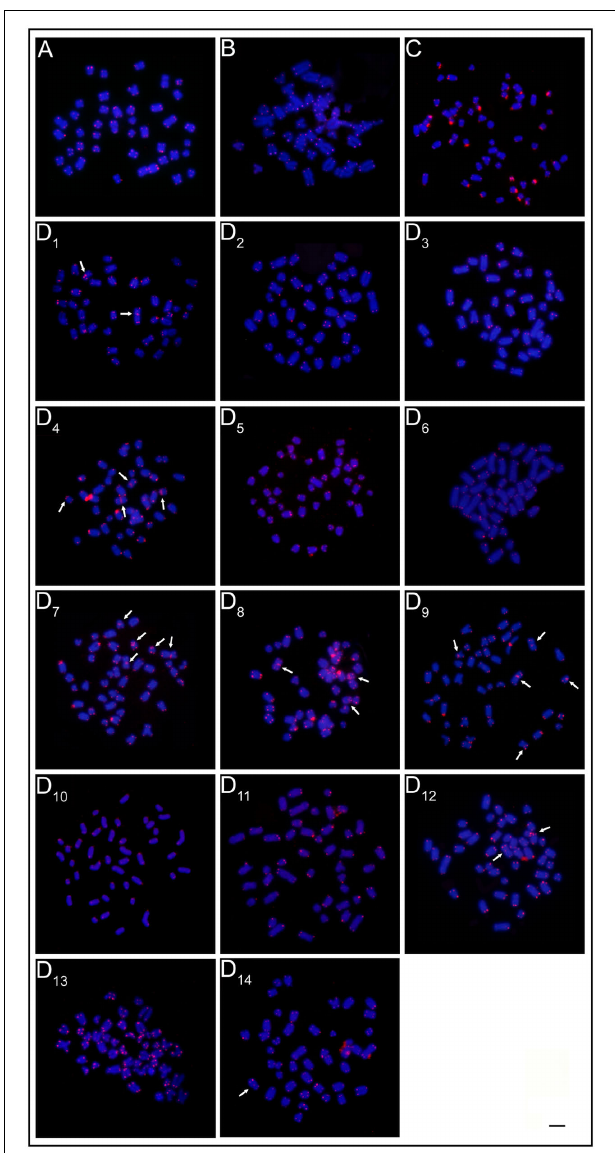
FIGURE 4 | FISH with telomeric probe. (A) ESU-A Igarapé Jundiá – Cuieiras River, (B) SEU-B Demini River, (C) SEU-C Igarapé apeú – Guamá River, and (D 1 − D 14 ) SEU-D 1 − 14 Purus River. Arrows indicate the occurence of interstitial telomeric sites (ITS). Bar = 10 µ m.